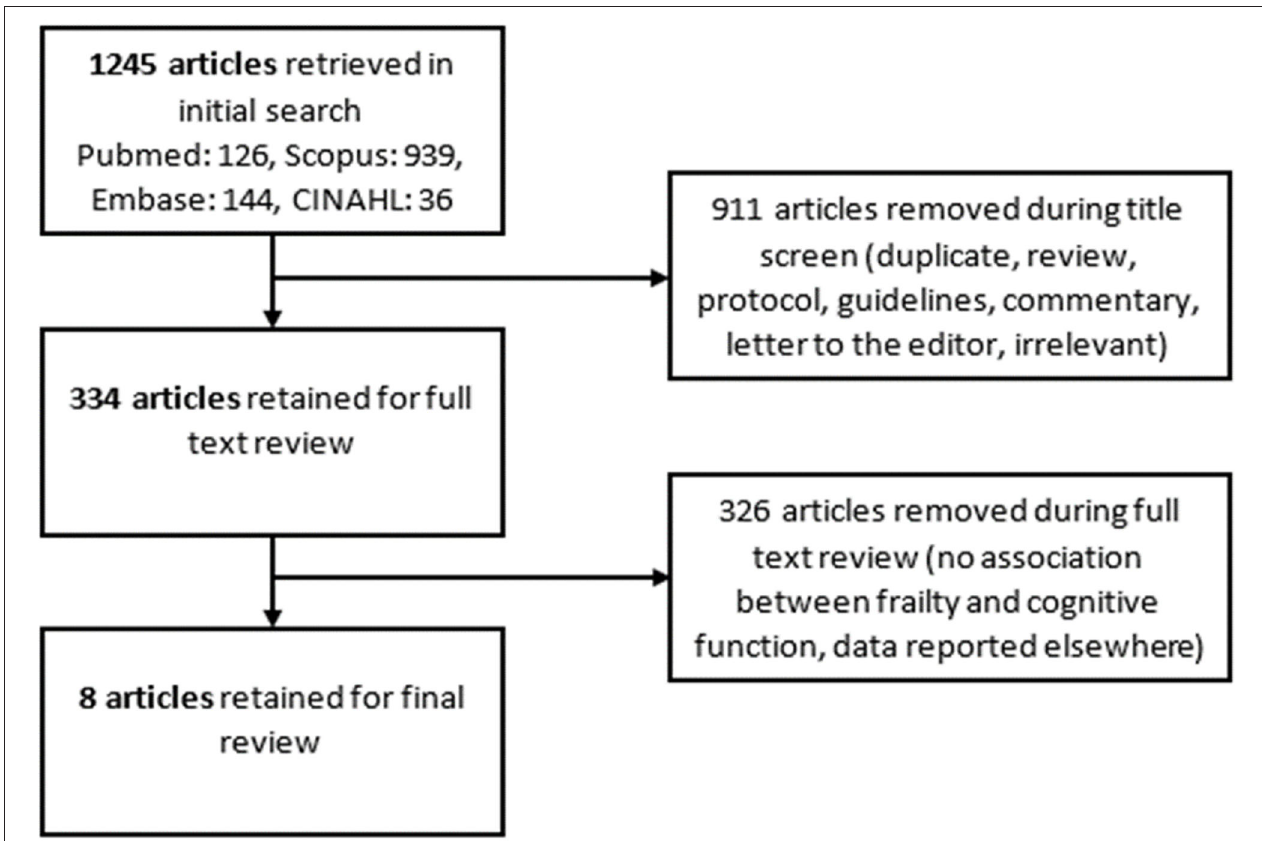
FIGURE 1 | Preferred reporting items for systematic reviews and meta-analyses (PRISMA) flowchart outlining the search for relevant literature for this integrative